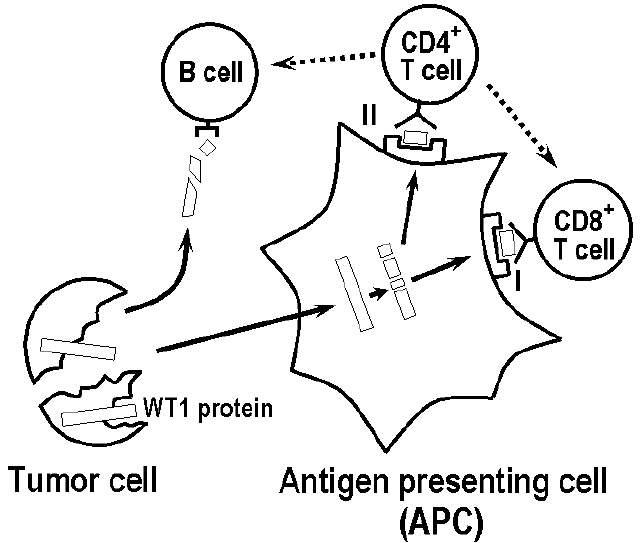
FIGURE 1. Spontaneous elicitation of immune responses against the WT1 protein. Tumor cell–derived WT1 protein stimulates B lymphocytes to produce anti-WT1 antibody, while the WT1 protein is ingested by APCs, such as dendritic cells (DCs), and is processed in them, followed by presentation of the WT1 protein–derived peptides in association with HLA molecules on the surface of the APCs. WT1 peptide/HLA class I complexes stimulate CD8 + T cells to make WT1-specific CTLs. WT1 peptide/HLA class II complexes stimulate CD4 + T cells to make WT1-specific, helper T cells, which more activate CTLs and B cells, respectively. The B cells “helped” by the helper T cells produce class-switched IgG-type, as well as IgM-type, anti-WT1